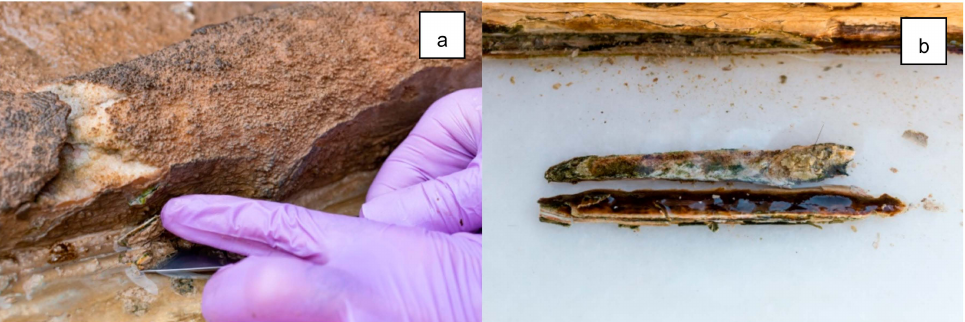
Figure 4. ( a ) Sampling a mineralising crust with a scalpel at Fuente N del Patio de los Arrayanes . ( b ) Two sheeted crusts from perpendicular angles with buried communities. Photos by G. Alfano.